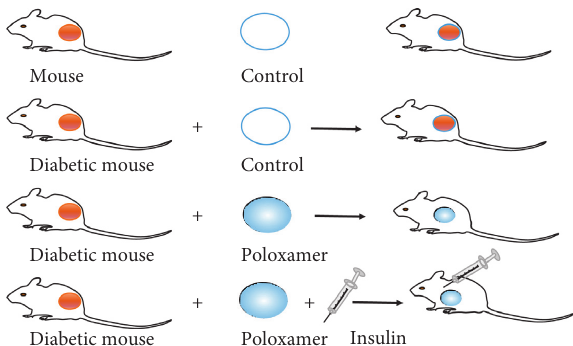
Figure 1: The experimental mice model: control, diabetic mouse (DControl), poloxamer (Pox), and poloxamer plus insulin